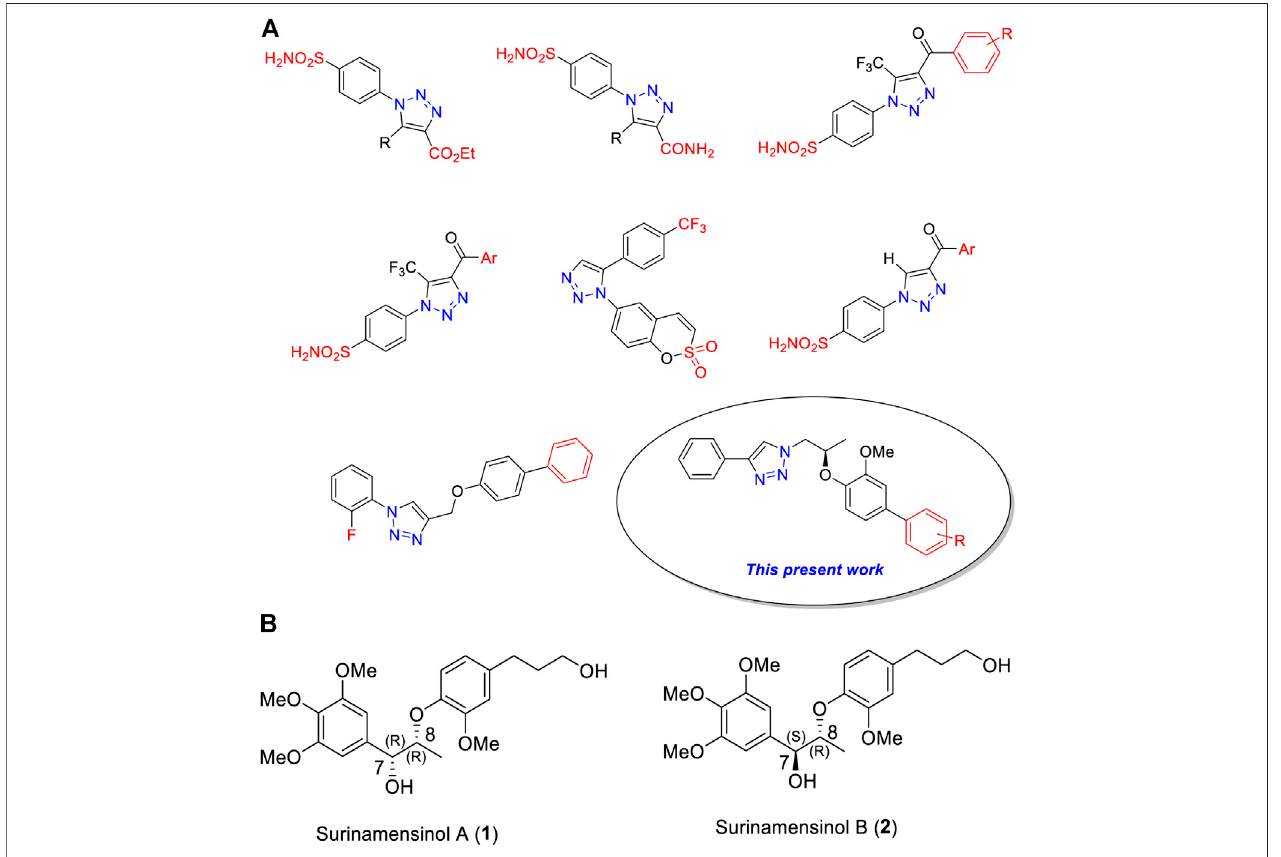
FIGURE 1 | (A) Chemical structures of some clinically used 1 H -1,2,3-triazole analogs as potential carbonic anhydrase-II inhibitors. (B) Chemical structures of surinamensinols A and B.